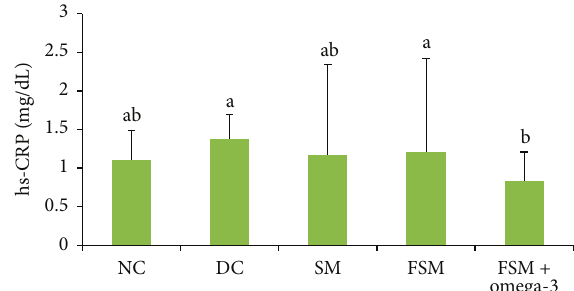
Figure 1: MDA level within the five groups. NC = normal control, DC = diabetic control, SM = diabetic rats that received soymilk, FSM = diabetic rats that received fermented soymilk, and FSM + omega-3 = diabetic rats that received fermented soymilk fortified with omega-3. Each value is expressed as mean ± SD. Values with different letters are significantly different at P < 0.05 as analyzed by Duncan’s multiple range test.